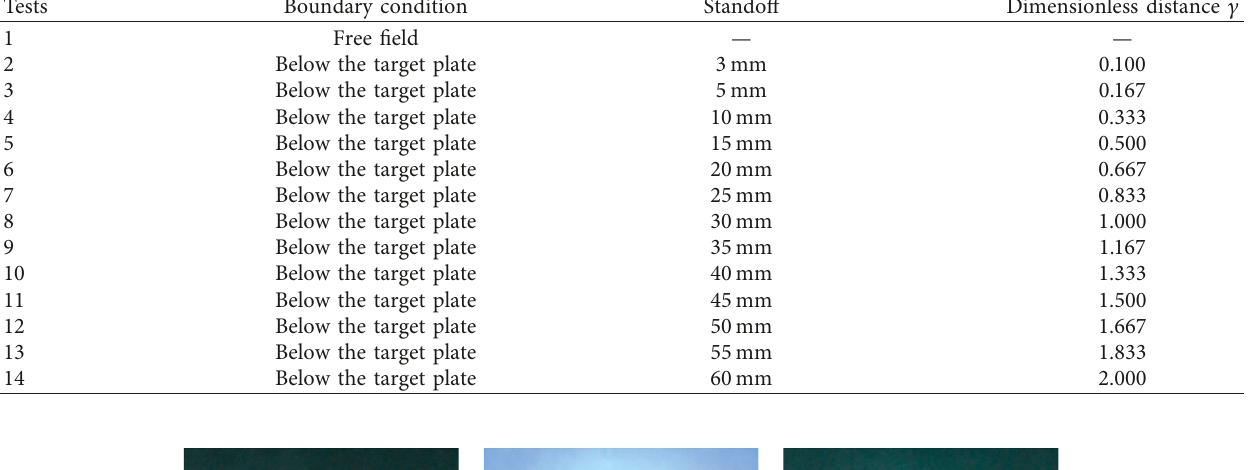
Table 1: Test planes.